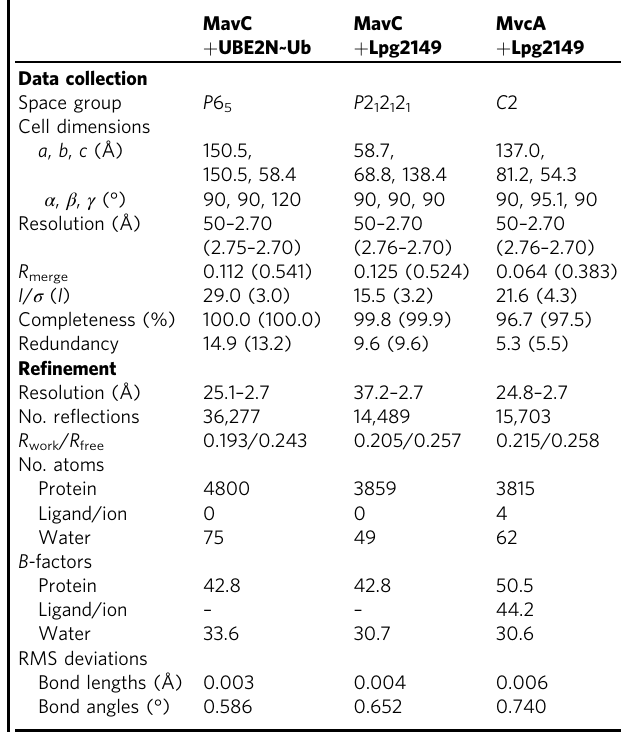
Table 1 Data collection and re fi nement